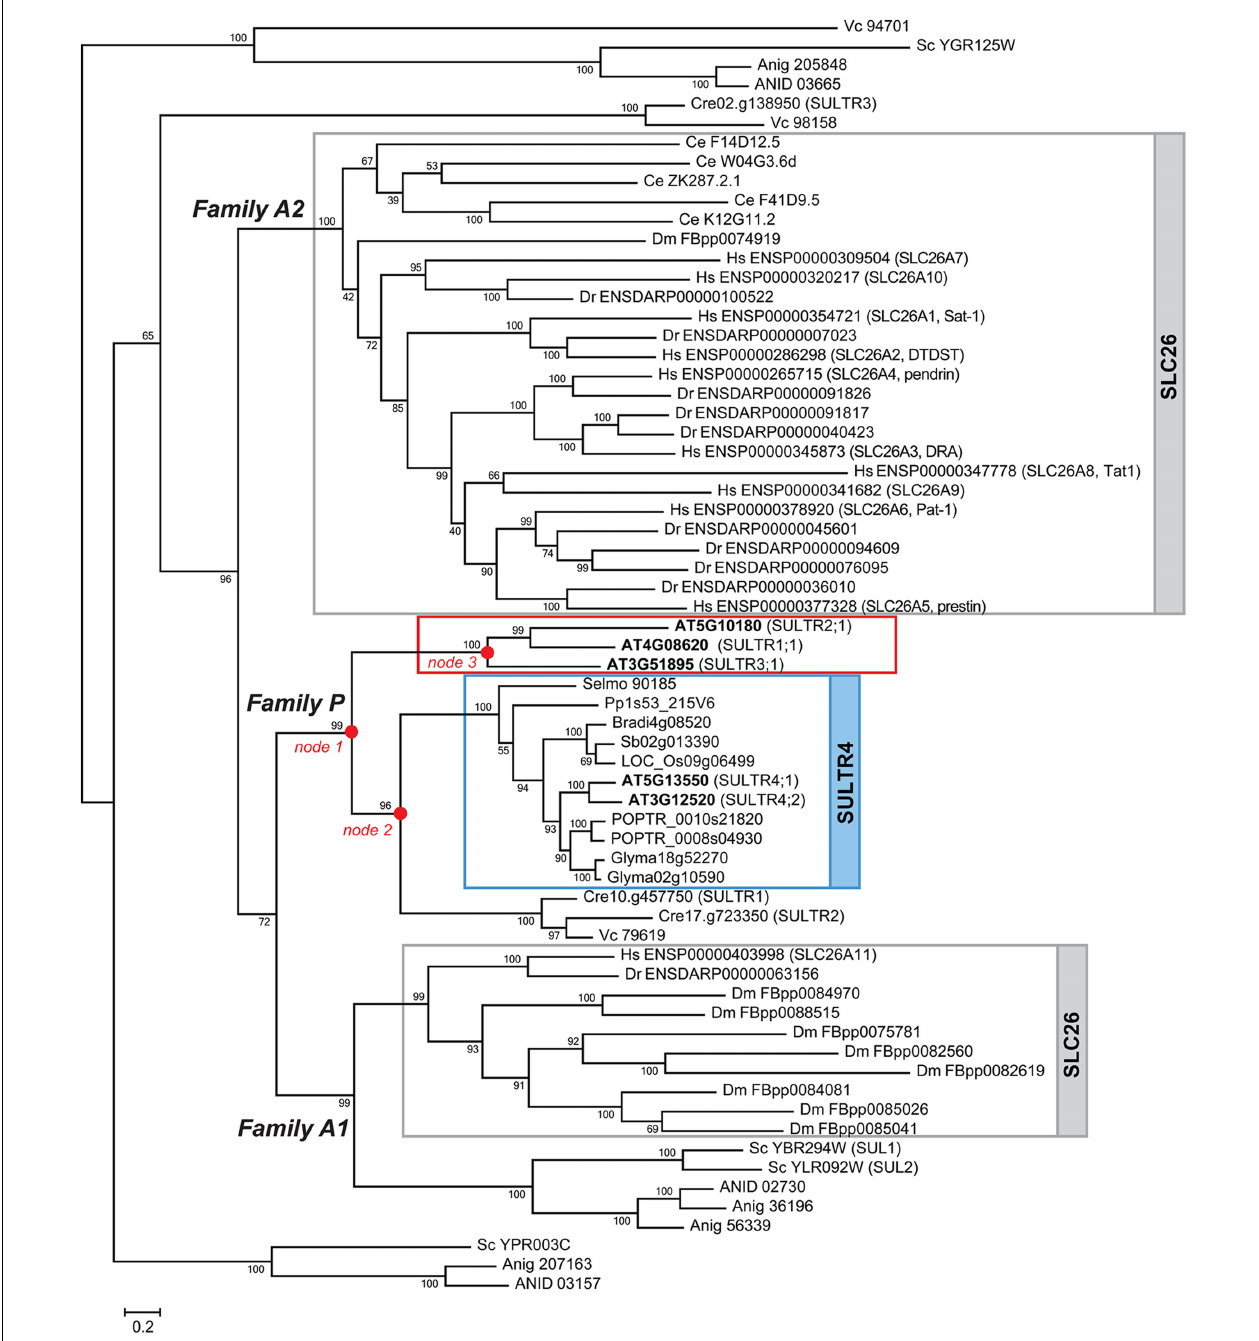
Prefix abbreviations of locus numbers or gene IDs indicate genus and species names: AT, Arabidopsis thaliana ; ANID, Aspergillus nidulans ; Anig, Aspergillus niger ; Bradi, Brachypodium distachyon ; Ce, Caenorhabditis elegans ; Cre, Chlamydomonas reinhardtti ; Dr, Danio rerio ; Dm, Drosophila melanogaster ; Glyma, Glycine max ; Hs, Homo sapiens ; Os, Oryza sativa ; Pp, Physcomitrella patens ; POPTR, Populus trichocarpa ; Selmo,